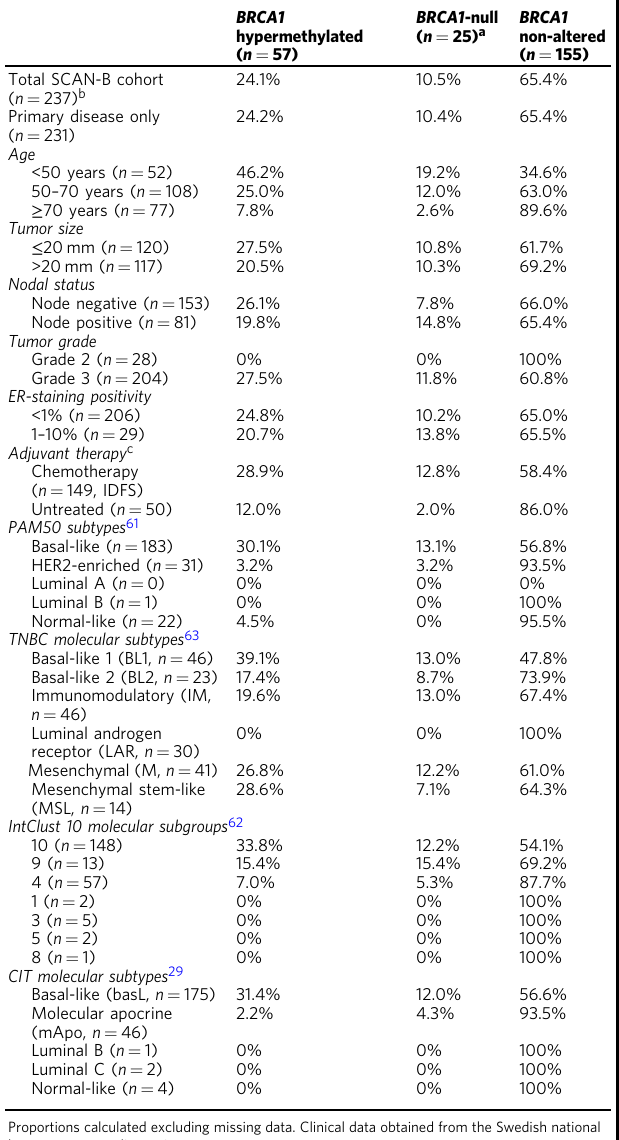
Proportions calculated excluding missing data. Clinical data obtained from the Swedish national breast cancer quality registry. a BRCA1 -null includes both germline and somatic cases. b Numbers for each reported group are provided for reference. c Only includes cases eligible for outcome analysis by invasive disease-free survival